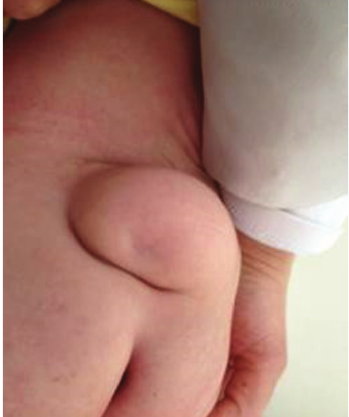
Figure 2: The meningomyelocele in the sacral area.